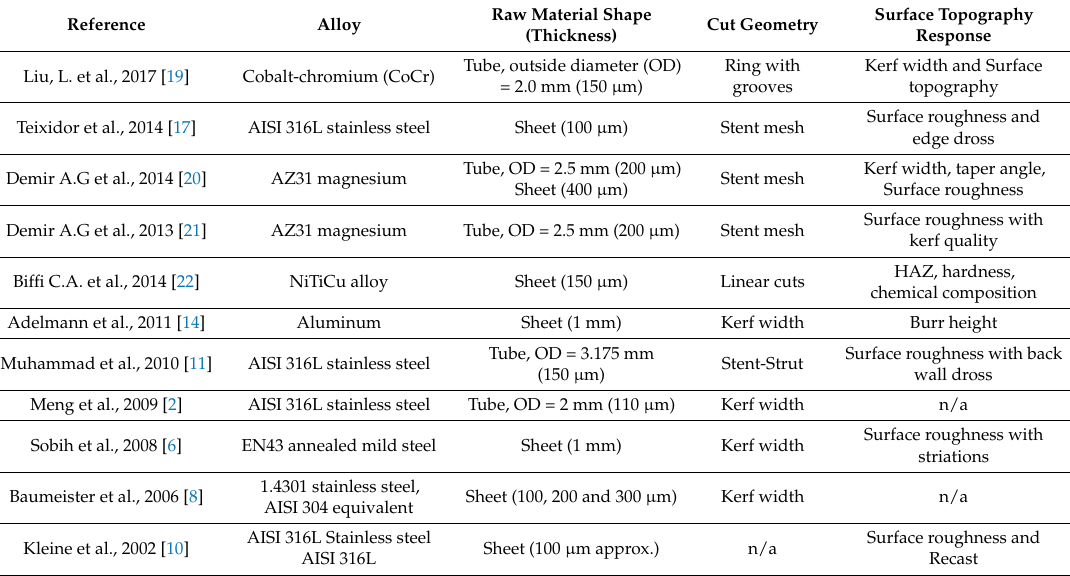
Table 1. State-of-the-art of fiber laser microcutting with stainless steel and other alloys.